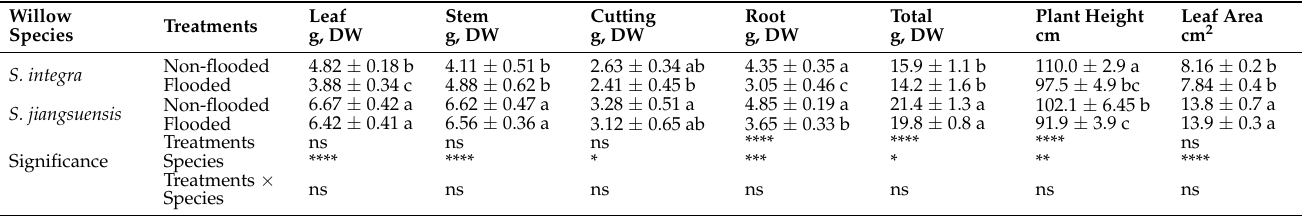
Table 1. Biomass of S. integra and S. jiangsuensis exposed to Cu-contaminated soil as affected by flooding for 90